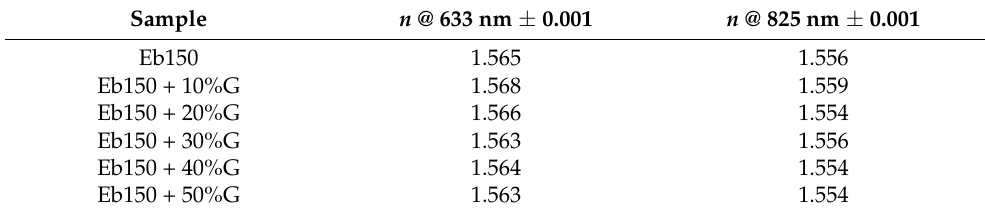
Figure 8. Transmittance spectra of UV-LED cured films loaded with different amounts of phosphate glass particles. Table 4. Refractive index of UV-LED cured films at 633 and 825 nm.